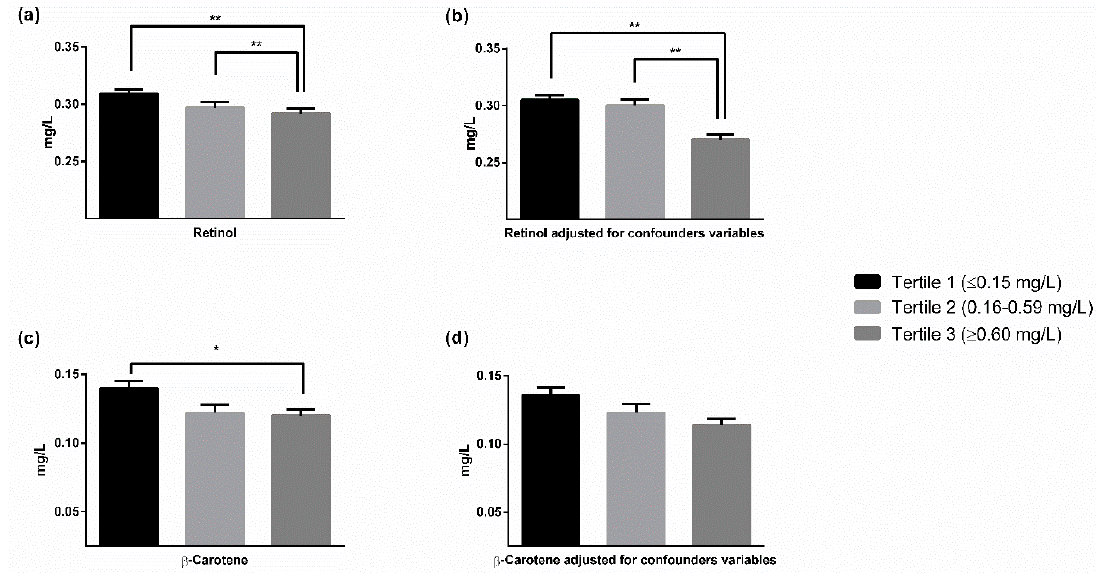
Figure 1. ( a ) Plasma levels of retinol (mg/L) according to hs-CRP tertiles unadjusted; ( b ) plasma levels of retinol (mg/L) according to hs-CRP tertiles adjusted for confounders variables; ( c ) plasma levels of β -Carotene (mg/L) according to hs-CRP tertiles unadjusted; ( d ) plasma levels of β -Carotene (mg/L) according to hs-CRP tertiles adjusted for confounder variables. * p < 0.01, ** p <